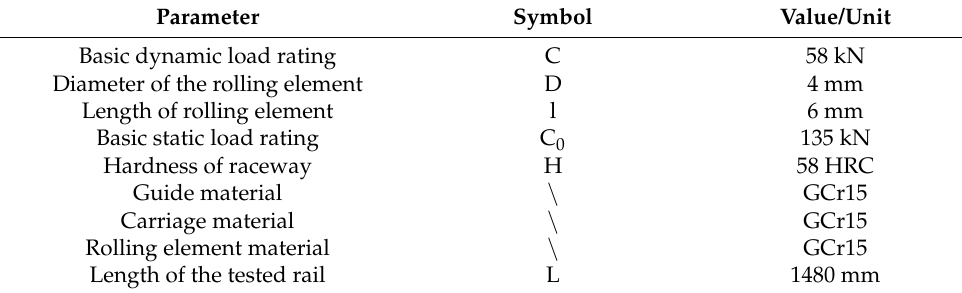
Table 1. LMRB parameters.